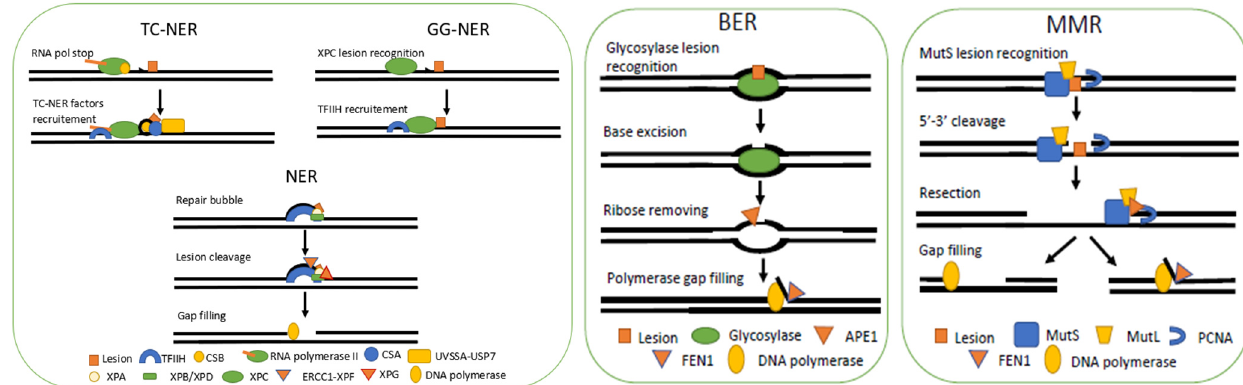
Figure 2. DNA base repair pathways. Simplified schematic representation of Nucleotide Excision Repair (NER), Base Excision Repair (BER), and Mismatch Repair (MMR). Transcription Coupled NER (TC-NER) starts with RNA pol II stalling in front of a lesion. Then CSB recruits CSA and UVSSA-USP7 allowing the TFIIH docking. Global Genome NER (GG-NER) is initiated by XPC lesion recognition. Through a cascade of events, TFIIH is recruited. Both NER pathways converge when TFIIH is recruited. Thanks to its helicases, XPB/XPD, and XPA, TFIIH creates a DNA repair bubble exposing the lesion. Then ERCC1-XPF and XPG cleave DNA around the lesion. The gap is then filled by DNA polymerase. In BER, glycosylase targets the lesion and cleaves base-deoxyribose glycosidic bounds. When Glycosylase is released from DNA, APE1 can now bind to cleave the faulty deoxyribose. DNA polymerase fills the gap and displaces some of the damaged strands. The resulting 3 ′ tail is then removed by FEN1. In MMR the mismatch is targeted by MutS, then recruiting MutL. Then an endonuclease cleaves DNA, and a resection occurs. Finally, polymerase fills the gap and could create a 3 (cid:48) overhang